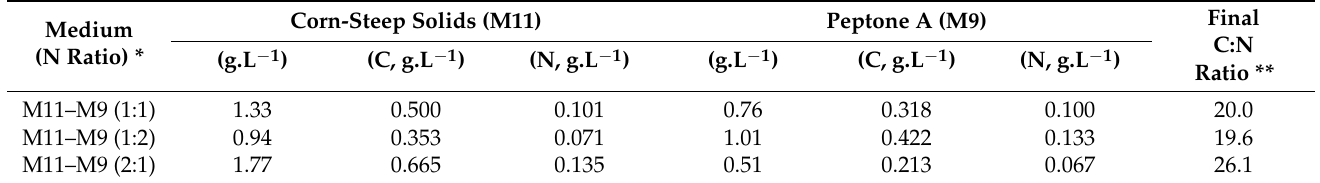
Table 2. Mixtures of corn-steep solids (M11) and peptone A (M9) in a chitin-containing medium were used for Aeromonas caviae CHZ306